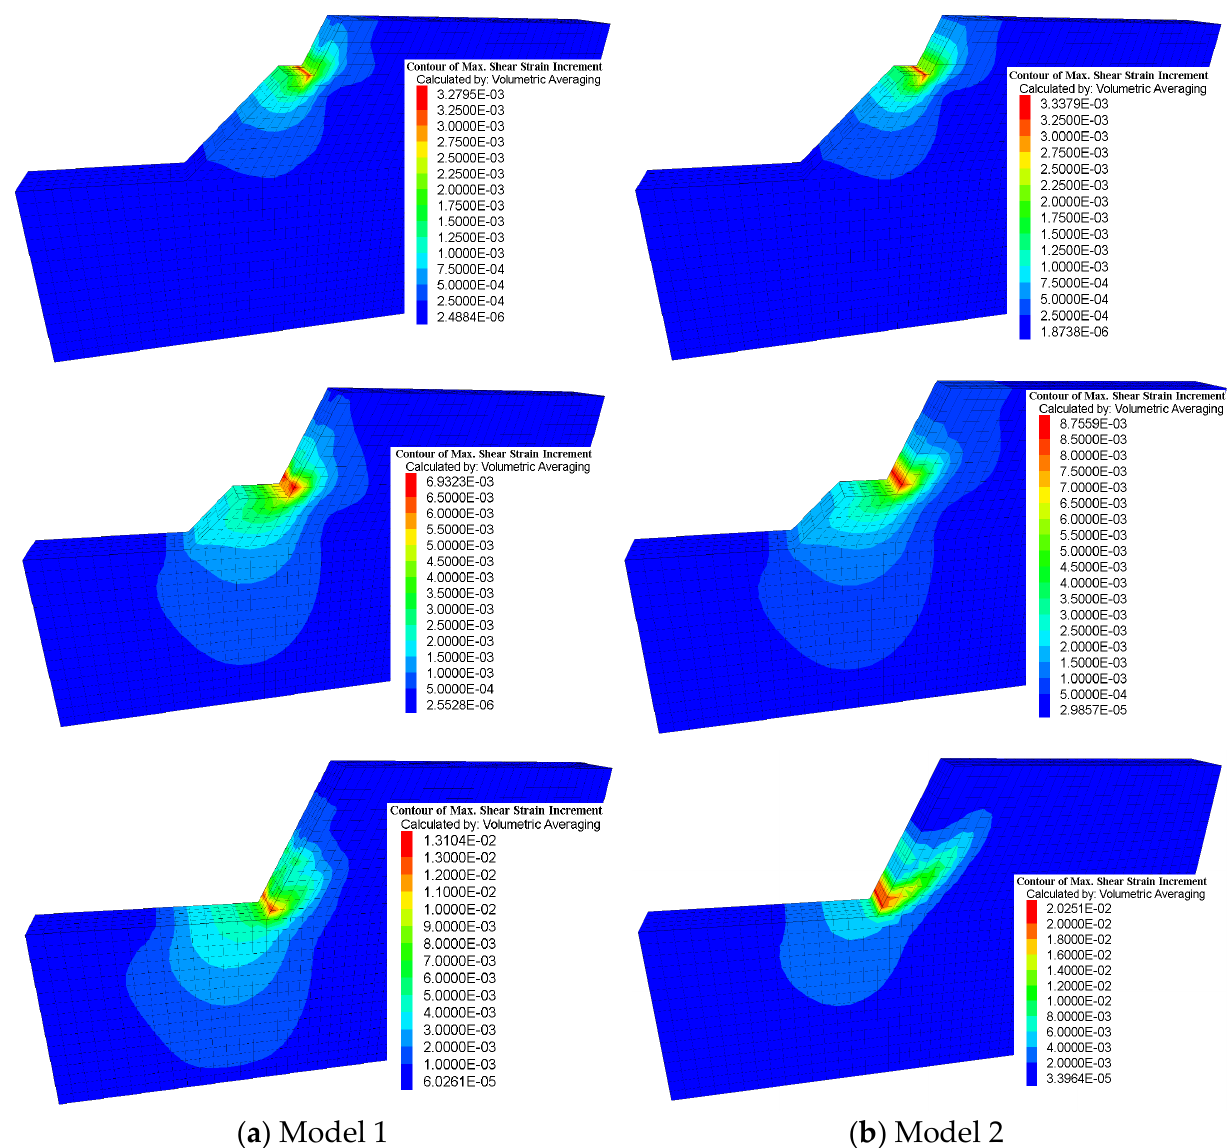
Figure 7. Comparison of MSSI for both models under different stages. Figure 7 shows the comparison of the developments and evolution of MSSIs for both models under different excavation stages. Due to the constraint effect of the anchors set in model 1 in advance, the contours of the MSSI show three-dimensional distribution characteristics, while the contours of the MSSI for model 2 without pre-arranged anchors show plane characteristics. Additionally, the MSSIs of both models gradually develop downward and appeared near the bench surfaces beneath each excavation level with